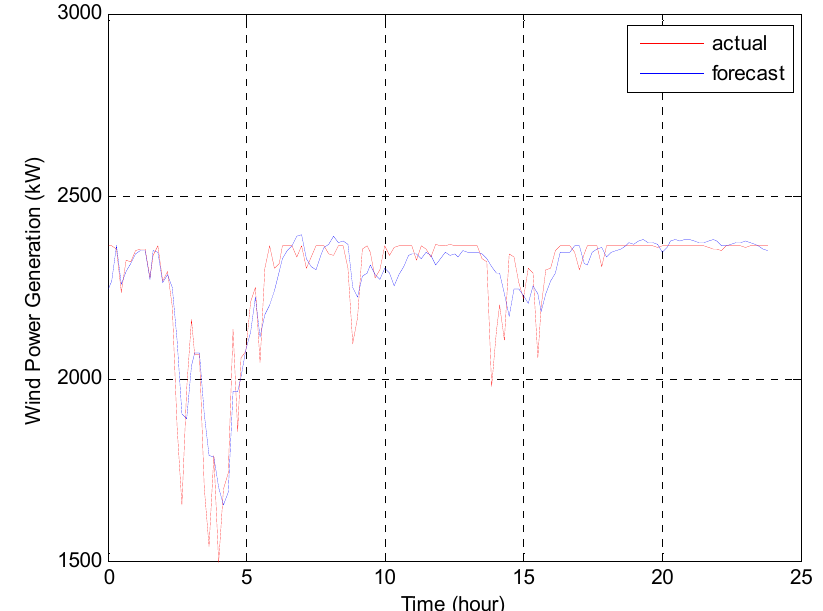
Figure 3. Numerical results with the proposed hybrid method for typical winter